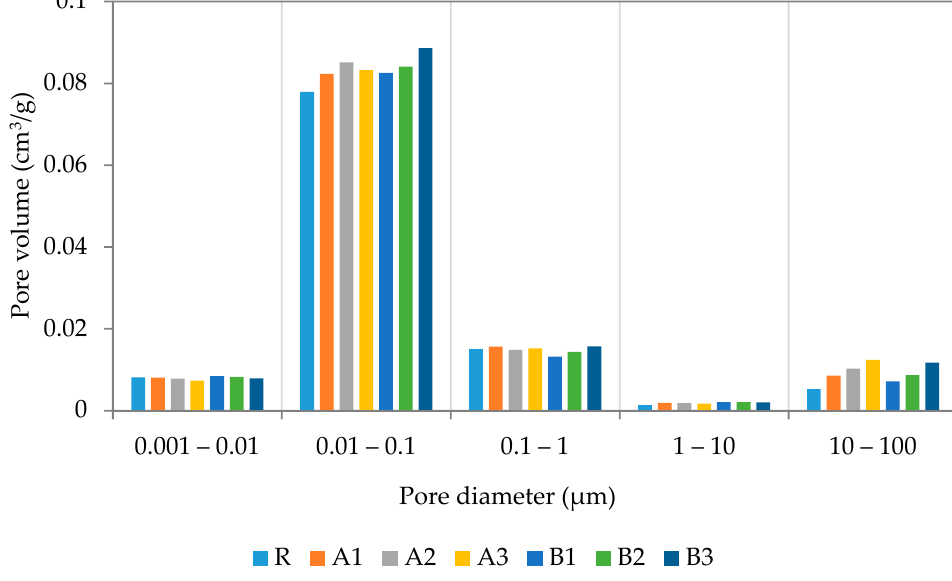
Figure 9. MIP of the designed cement mortars at 180 days.